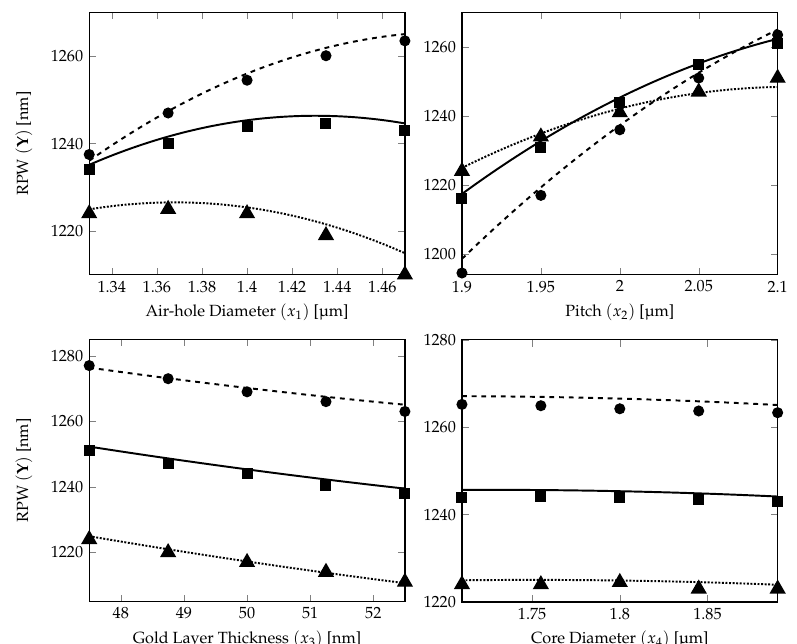
Figure 7. Effects of four factors (air-hole diameter, pitch, gold layer thickness and core diameter of analyte) on RPW curves generated from quadratic CCD ± 5% model. The dotted, solid and dashed curves show the RPW calculated from the ± 5% DoE model (12) with three parameters (expected target parameter on x -axis) fixed at their own tolerance levels, − 5%, 0% and + 5%, respectively. −→ + 5%) are calculated from corresponding The RPW marks ( (cid:78) −→ − 5%, (cid:4) −→ 0% and (cid:32) FEM simulations.